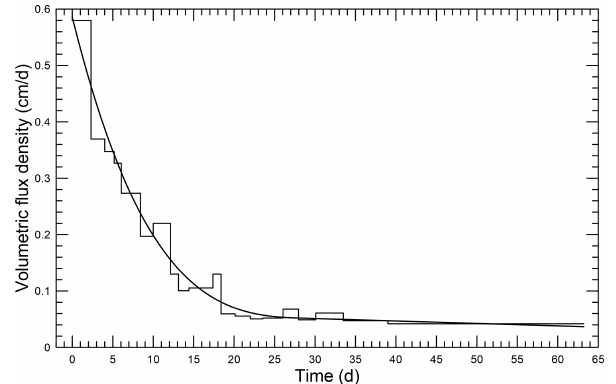
Figure 3. The x = 0 boundary condition – the volumetric flux den- sity at the boundary. The step function shows the measured values, and the smooth function is its approximation used in the solved ex-